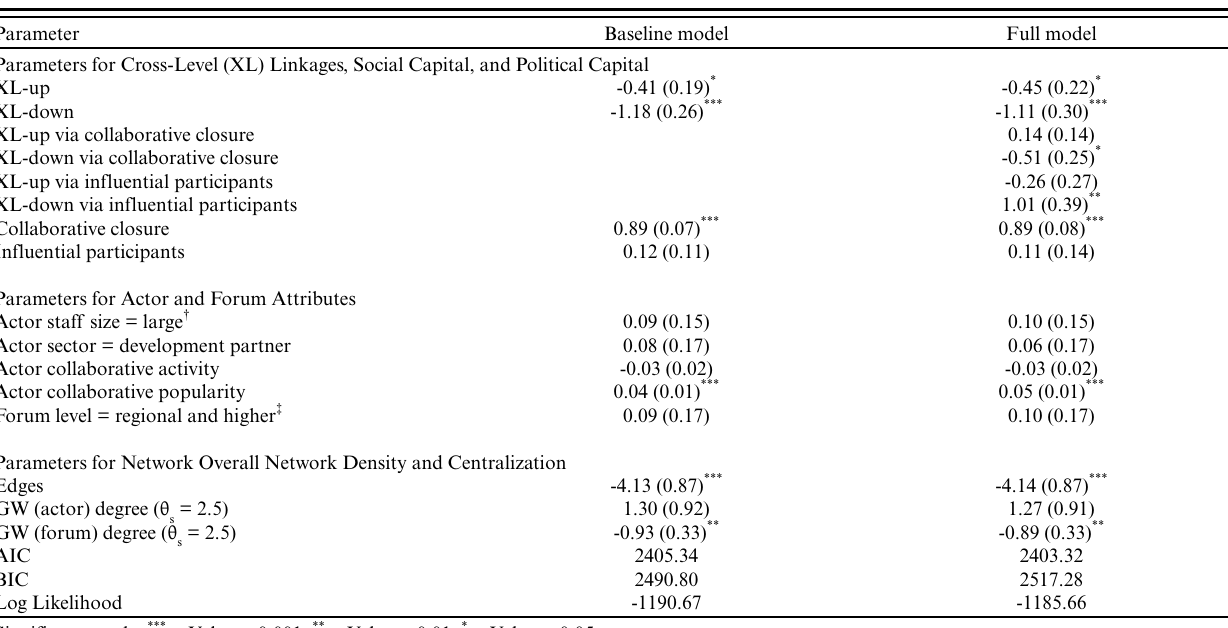
Table 2 . Results of exponential random graph